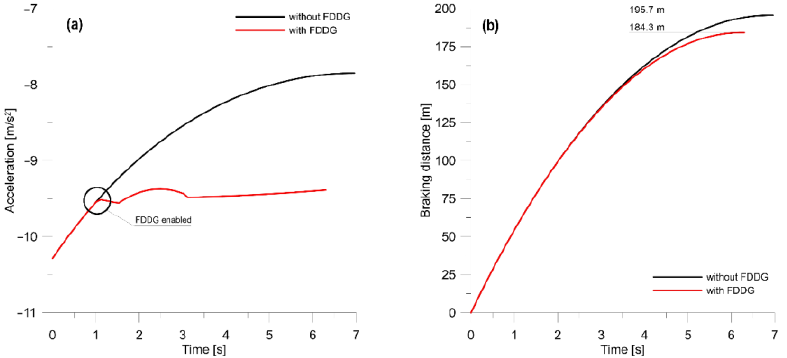
Figure 36. Comparison of car performance equipped with FDDG and without it in braking from a set speed of 216 km/h: ( a ) Deceleration; ( b ) Braking